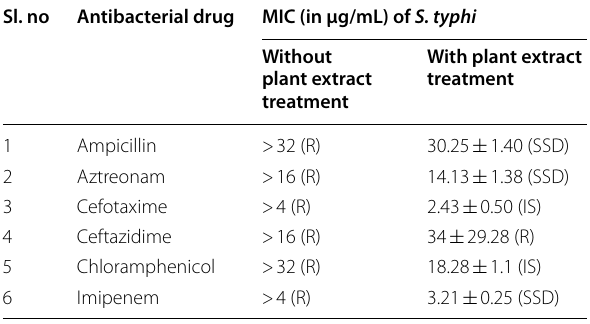
R resistant, SSD susceptible-dose dependent, IS intermediate